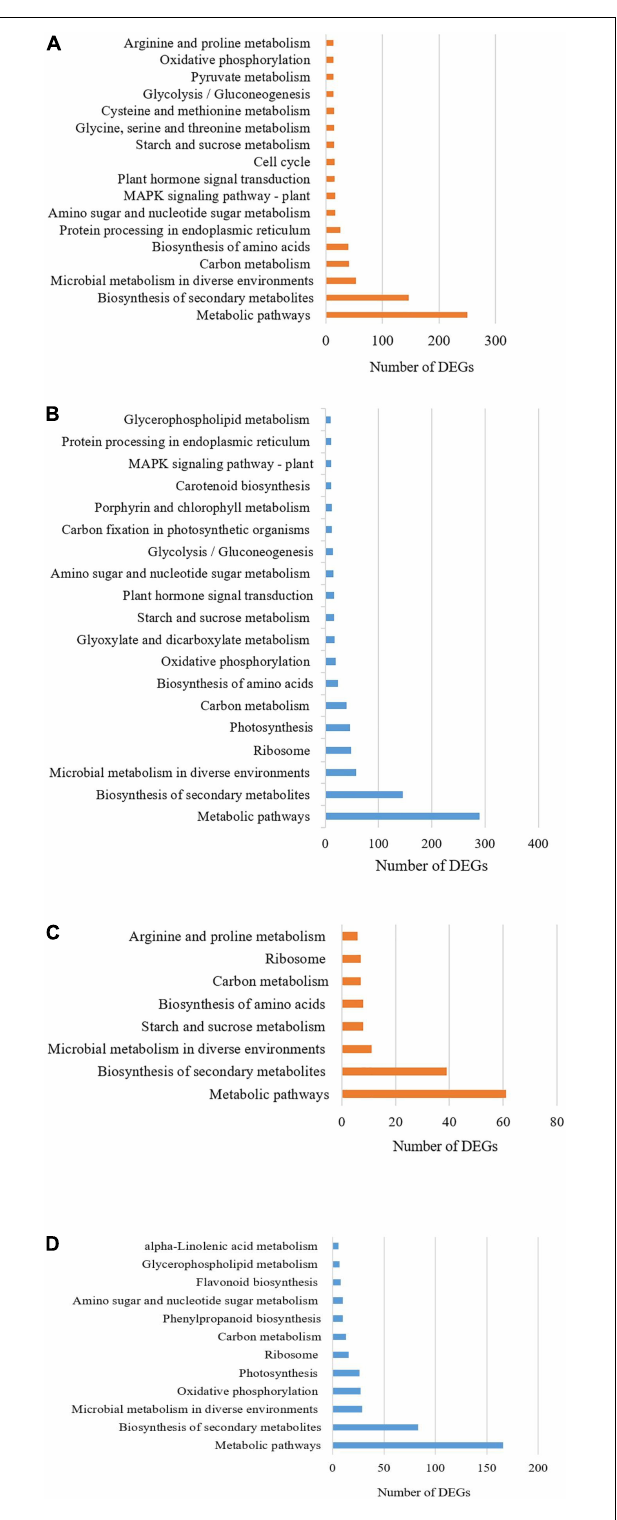
FIGURE 2 | KEGG pathway classification of the differentially expressed genes (DEGs) (A) up-regulated and (B) down-regulated in salt-tolerant genotype; as well as (C) up-regulated and (D) down-regulated in sensitive barleys grown under contrasting environments (control vs. salt stress).